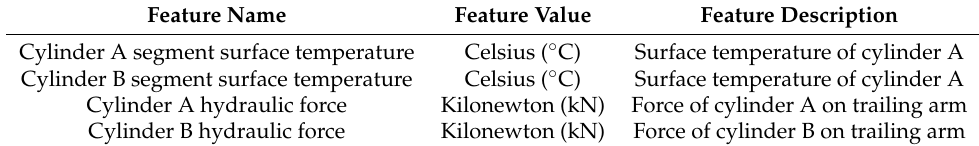
Table 1. Features.